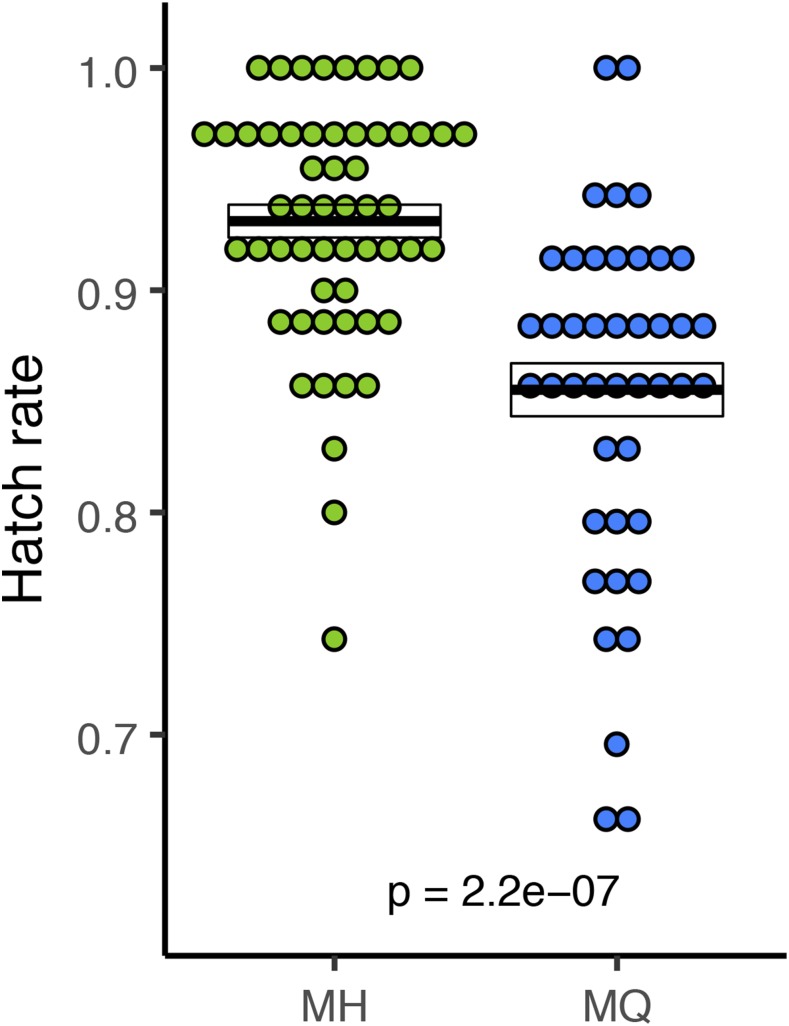
Egg hatch rate. Each point represents the hatch rate of a set of 25 to 40 embryos. Sample sizes are n = 55, n = 43 embryo sets, for MH and MQ respectively. Crossbars represent mean ± SE with p-value corresponding to a Wilcoxon test on MH vs. MQ.